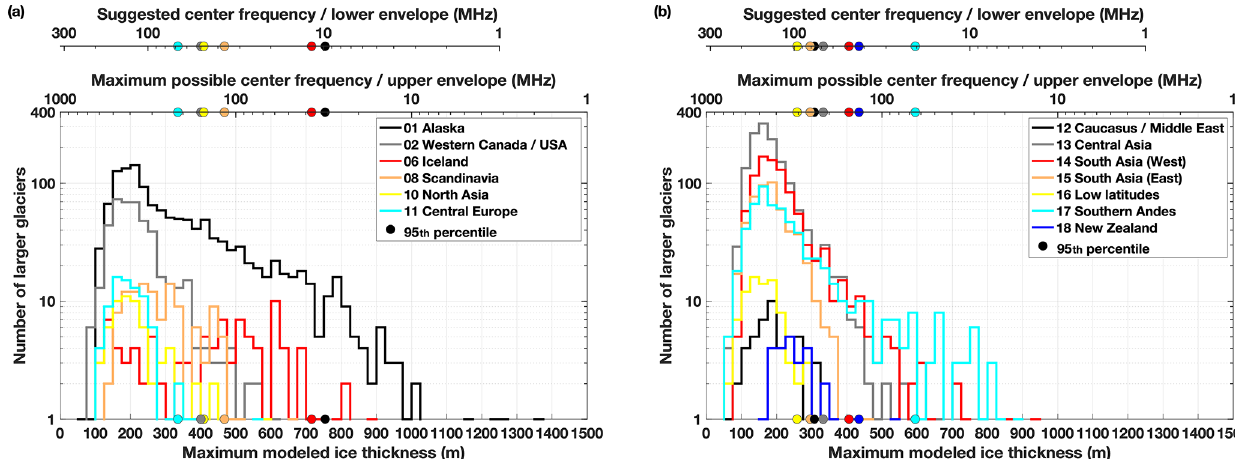
Figure 2. Distribution (lines) and 95th percentile (circles) of maximum modeled ice thickness for all larger ( ≥ 5km 2 ) glaciers in RGI regions assumed to contain mostly temperate glaciers. RGI regions are separated into two panels for readability. Bin interval is 25m. Upper horizontal axes are equivalent to the lower and upper bounds of the empirical envelope in Fig. 1, e.g., for a region whose 95th percentile maximum ice thickness is ∼ 500m, the maximum center frequency of a suitable radar sounder for that region is ∼ 100MHz, while ∼ 30MHz is a more conservative suggested